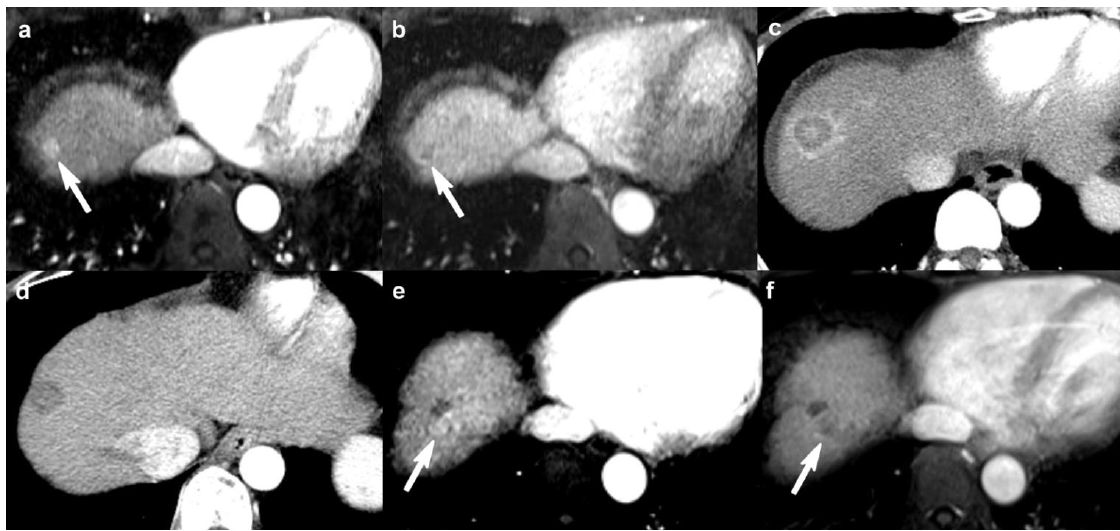
Figure 3. A 54-year-old man with HCC treated with RFA. ( a , b ) Pretreatment MR images on the arterial phase ( a ) and portal venous phase ( b ) show a 1.0-cm arterial enhancing and washout nodule on liver segment VIII dome (arrows), suggestive of HCC. ( c ) Immediate post-RFA CT image shows complete ablation of HCC, surrounded by expected post-treatment thin rim enhancement on the arterial phase. ( d ) Follow-up (after 3 months) CT image on the arterial phase shows no lesional enhancement in treated observation. This treated observation was assigned as LR-TR nonviable. ( e , f ) However, follow-up (after 3 years) MR images on arterial phase ( e ) and portal venous phase ( f ) show nodular arterial enhancement and washout at posterior margin of treated observation (arrows). This treated observation was assigned as LR-TR viable category and confirmed as viable HCC on explant pathology. HCC, hepatocellular carcinoma; RFA, radiofrequency ablation; MR, magnetic resonance; CT, computed tomography; LR-TR, Liver Imaging Reporting and Data System treatment